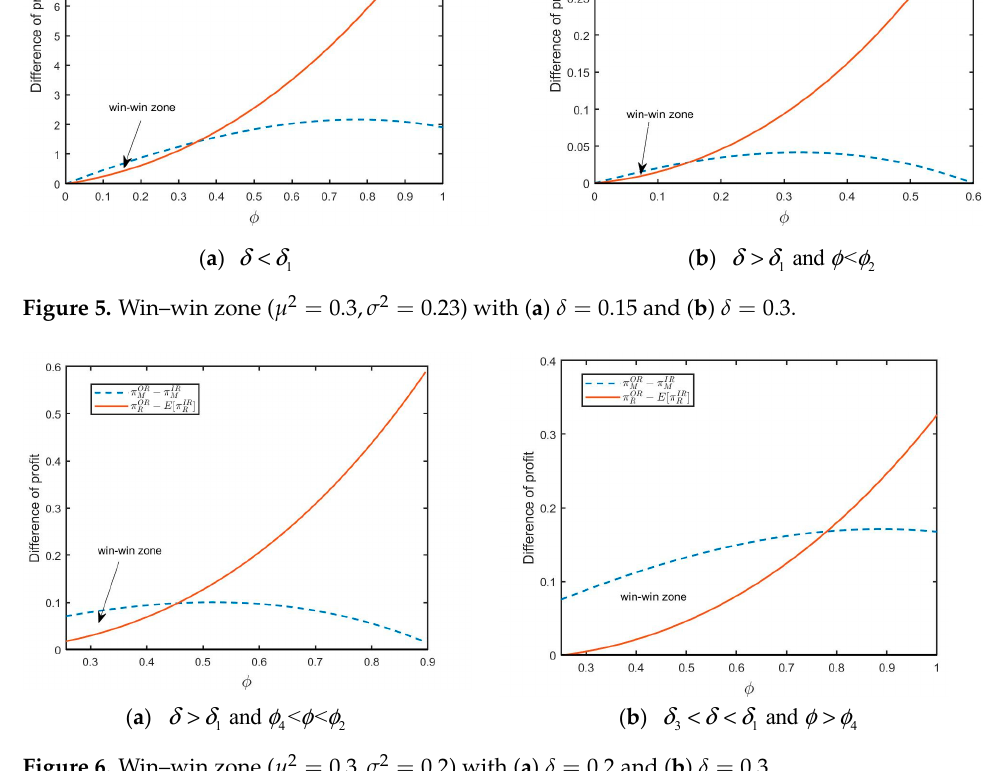
Figure 6. Win–win zone ( µ 2 = 0.3, σ 2 = 0.2) with ( a ) δ = 0.2 and ( b ) δ =